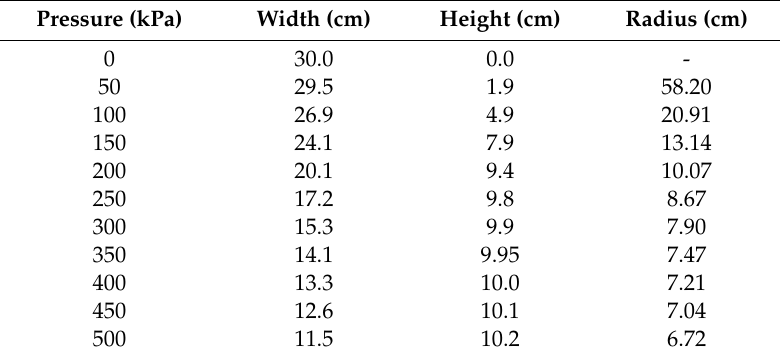
Table 5. The dimensions of the Arc of the SBCA at di ff erent air pressures.